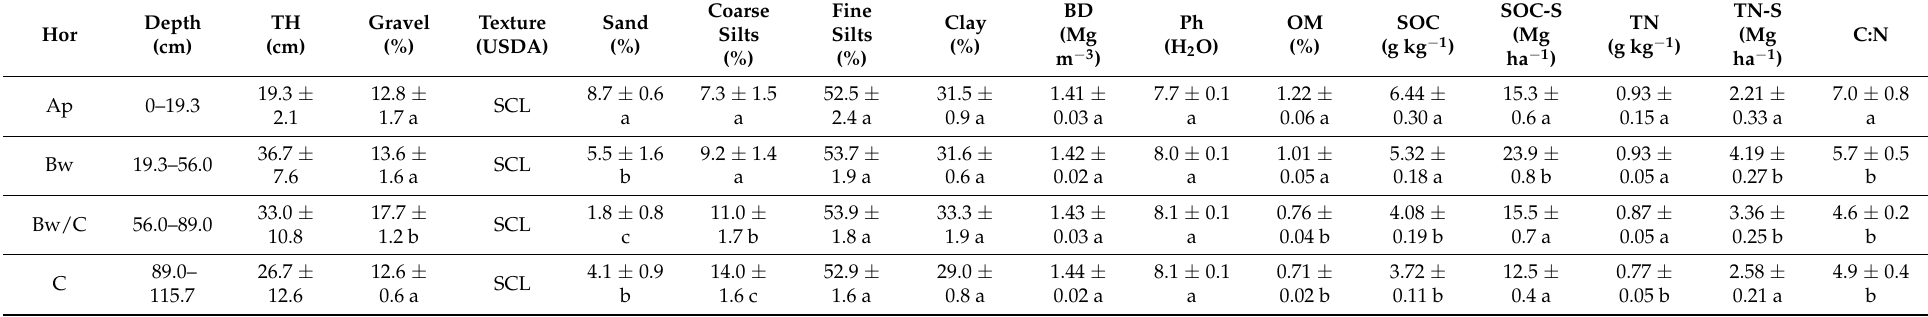
Table 4. Principal soil properties evaluated (average ± SD) in the soil profile by horizons in the study area. Preoperational stage, CT0 (January 2003). Data are means ± SD ( n = 3).